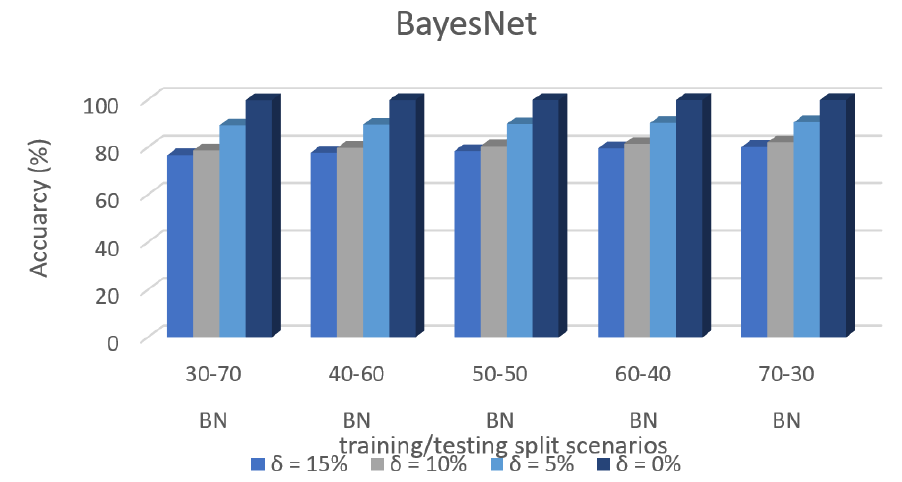
Figure 16. Accuracy Prediction for Dataset 3 using Bayesian Network Algorithm.